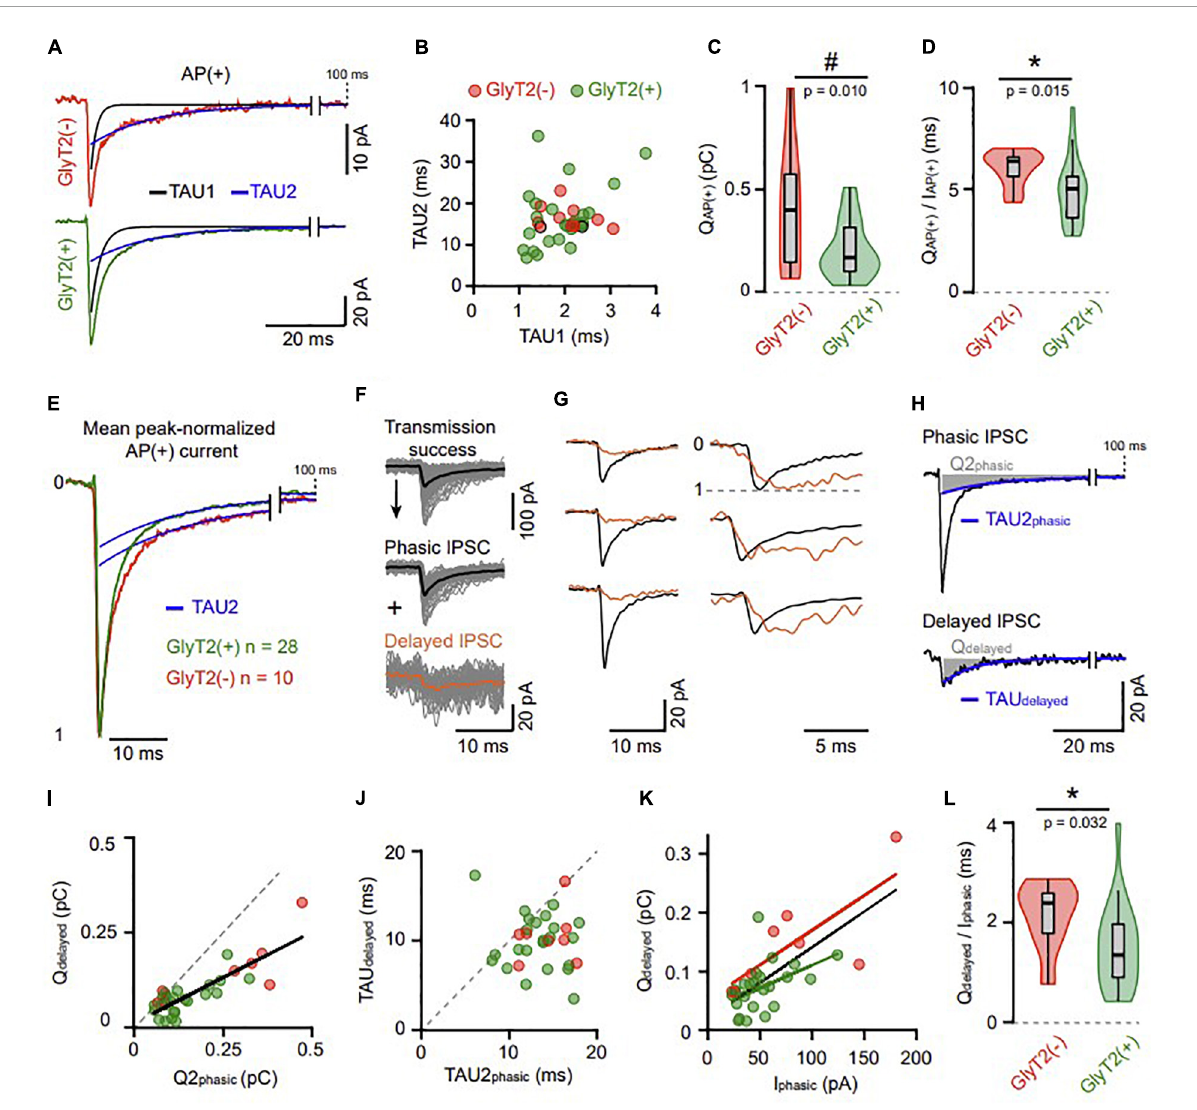
FIGURE4 Different types of IPSCs unravel decreased and variable GABA transient at GlyT2(+) synapses. (A) Example of GlyT2( − ) and GlyT2(+) AP(+) averaged traces both adjusted by a bi-exponential function. The two decay components have a fast (black) and a slow (blue) time constant named TAU1 and TAU2, respectively. (B) Correlation between the two fitted time constants in connected GoC-GrC pairs [ n = 36, GlyT2( − ) n = 10, GlyT2(+) n = 26]. The two dots outlined in black are the individual examples in panel (A) . GlyT2( − ): TAU1 = 2.04 ± 0.51 ms, TAU2 = 16.56 ± 2.73 ms, n = 10; GlyT2(+): TAU1 = 1.94 ± 0.62 ms, TAU2 = 16.41 ± 7.17 ms, n = 26; TAU1 GlyT2( − ) vs. TAU1 GlyT2(+), p = 0.46, TAU2 GlyT2( − ) vs. TAU2 GlyT2(+), p = 0.58. (C) Violin plot distribution of the synaptic charge [Q AP ( + ) ] calculated from bi-exponential fit (A1*TAU1 + A2*TAU2) of mean AP(+) current. The “#” indicates a significant difference for the Conover test of variance. (D) Violin plot distribution of the ratio between QAP(+) and the peak amplitude of AP(+) current [I AP ( + ) ] ( Figure 2B ). (E) Mean peak-normalized AP(+) current of the GlyT2( − ) and GlyT2(+) pairs ( n = 10 and n = 28, respectively). The superposed blue traces are the second decay component from the bi-exponential function [same fitting procedure as panel (A) ]. (F) Transmission success from a representative pair decomposed in phasic (average trace in black) and delayed (average trace in orange) events (see details in section Materials and methods). (G) Examples exhibiting kinetics difference of phasic and delayed events (left: average traces; right: peak-normalized traces). (H) Average phasic and delayed IPSC of a pair adjusted with a bi- and a mono-exponential function reciprocally. In blue, the second decay component of the phasic IPSC (TAU2 phasic ) and the single decay component of the delayed IPSC (TAU delayed ) . The areas shaded in gray represent the charge of the corresponding decay component in phasic (Q2 phasic = A2*TAU2 phasic ) and delayed (Q delayed = A*TAU delayed ) events. The peak amplitude of the phasic IPSC (I phasic ) did not differ significantly between GlyT2(+) and GlyT2( − ) pairs. (I) Correlation between Q2 phasic and Q delayed . (J) Correlation between the decay time constant of delayed IPSCs (TAU delayed ) and the second one of phasic IPSCs (TAU2 phasic ). (I,J) The gray dotted lines are diagonals, and exhibit a lack of charges and time in delayed IPSCs compared to the phasic ones. (K) Correlation between I phasic and Q delayed in the GlyT2( − ) and GlyT2(+) population. In black the correlation of all pairs pooled together (slope = 1.2 ms, r = 0.66, p < 0.0001, n = 31). (L) Violin plot distribution of Q delayed to I phasic ratio for GlyT2(+) and GlyT2( − ) pairs. These ratios are the slopes of each dot in panel (K) and depict that GlyT2(+) variability exceeds the one of GlyT2( − ) pairs. * p < 0 .